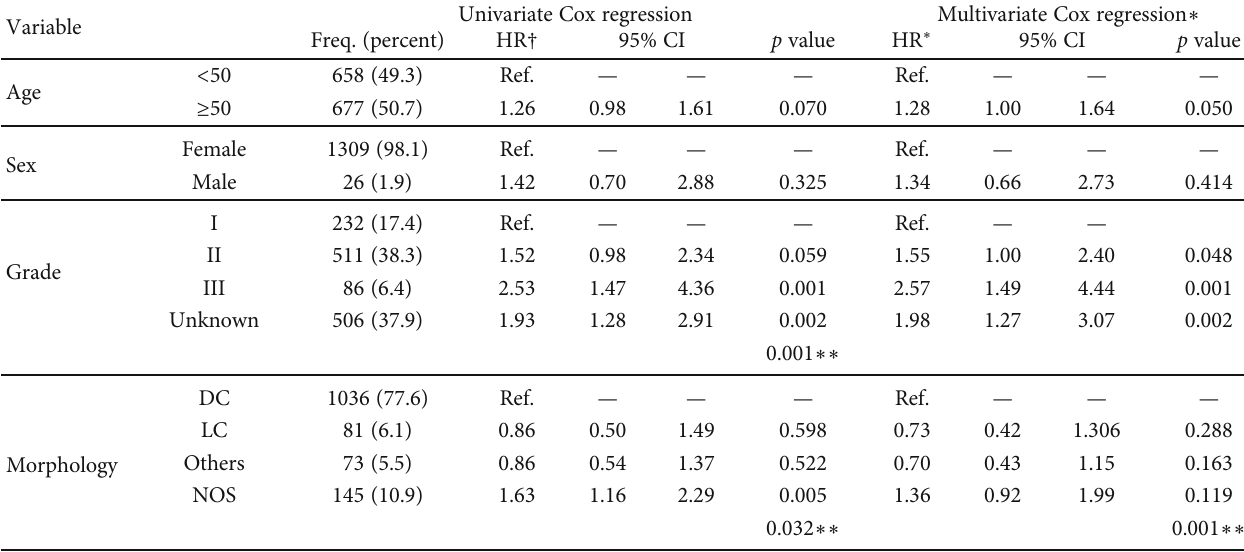
Table 2: Cox regression analysis of follow-up data of breast cancer patients in Northwest of Iran, between 2007 and 2016.